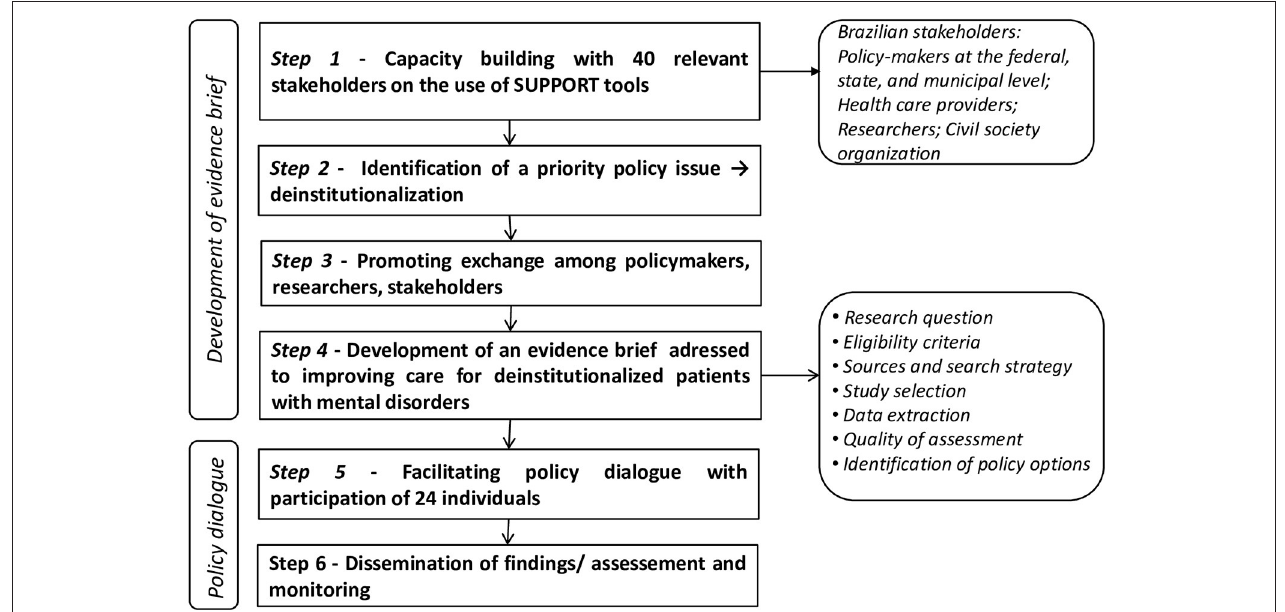
FIGURE 1 | Steps used on elaboration of evidence